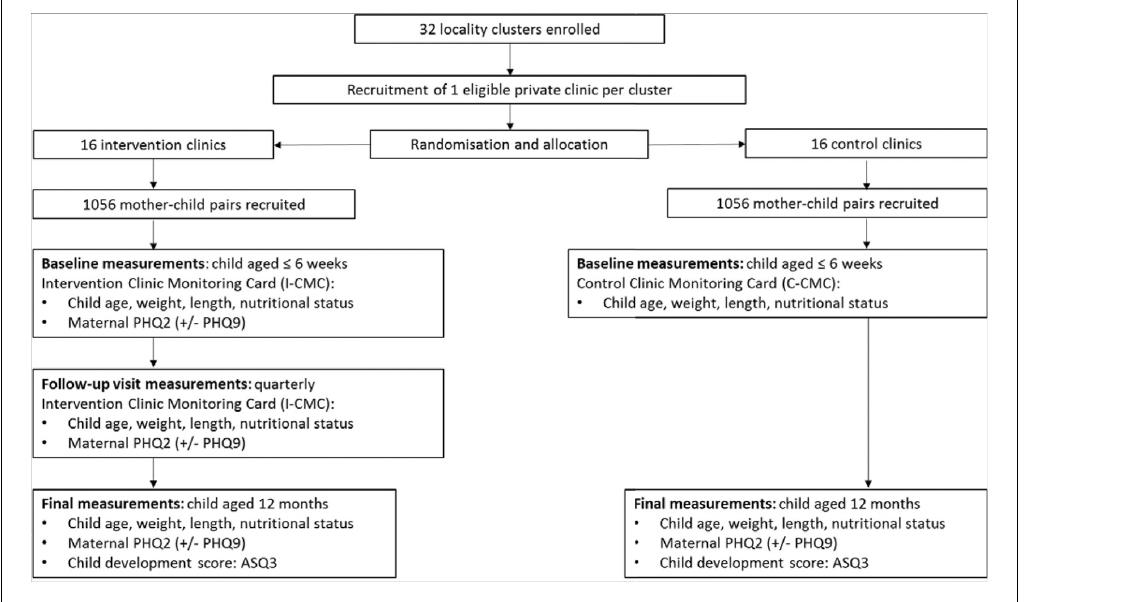
Figure 1. Trial flow